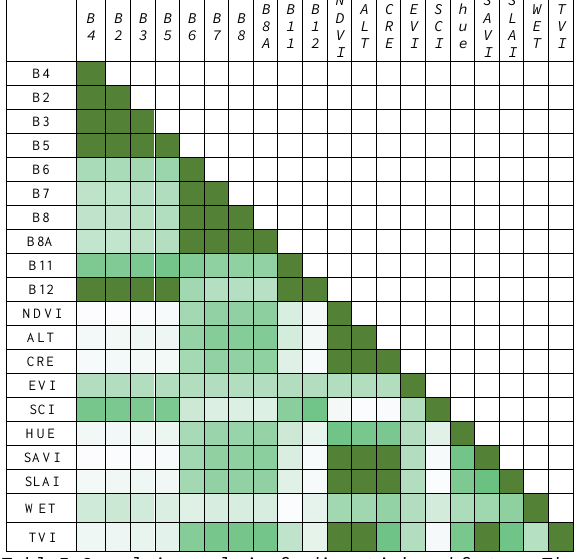
Table 5. Correlation analysis of radiometric-based features. The dark green cells indicate a correlation coefficient >0.85.